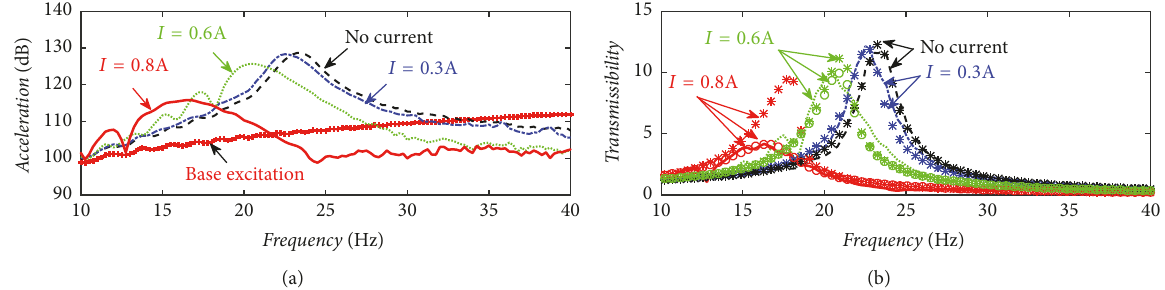
Figure 11: Experimental acceleration and transmissibility curves from frequency sweeps: (a) acceleration response and (b) transmissibility. Table 3: Comparison of the theoretical resonance frequency and the experimental resonance frequency for various current. Current (A) Theoretical resonance frequency